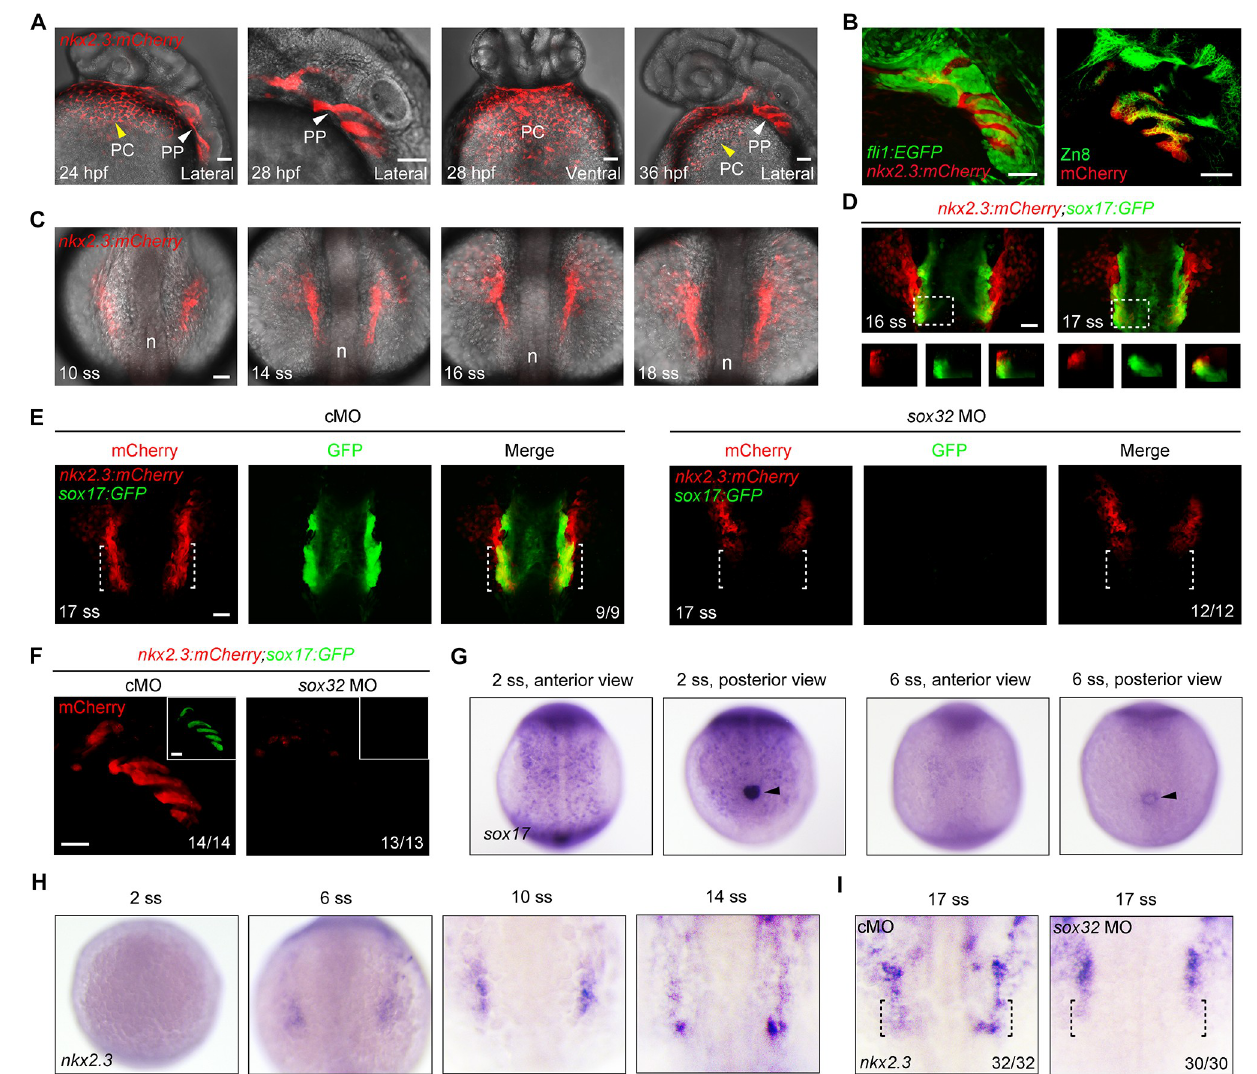
Fig 1. nkx2 . 3 is expressed in the lateral pharyngeal endoderm during early somite stages. ( A ) Tg(nkx2 . 3 : mCherry) embryos at 24, 28 and 36 hpf exhibiting fluorescence in the pericardium (yellow arrowhead) and pharyngeal pouches (white arrowhead). PC, pericardium; PP, pharyngeal pouch. Scale bars, 50 μ m. ( B ) mCherry-positive cells (red) were located between EGFP-labeled cranial neural crest cells (green) in Tg(nkx2 . 3 : mCherry;fli1 : EGFP) embryos (left panel), and co-localized with Zn8 labeled pharyngeal pouch cells (green) in Tg(nkx2 . 3 : mCherry) embryos (right panel). Scale bars, 50 μ m. ( C ) mCherry fluorescence in Tg(nkx2 . 3 : mCherry) embryos from the 10- to 18-somite stages. Embryos were dorsal views with anterior to the top. n, notochord; ss, somite stage. Scale bar, 50 μ m. ( D ) Tg(nkx2 . 3 : mCherry;sox17 : GFP) embryos with mCherry-positive cells (red) and GFP-labeled endodermal cells (green) at the 16- and 17-somite stages. The lower panels are optical transverse sections (XZ) taken at the level of white lines in their respective upper panels. Scale bar, 50 μ m. ( E-F ) mCherry (red) and GFP (green) fluorescence in Tg(nkx2 . 3 : mCherry;sox17 : GFP) embryos injected with 8 ng control MO (cMO) or 8 ng sox32 MO at the 17-somite stage (E) and 36 hpf (F). In panel F, the GFP fluorescence was shown in the inset. The ratios of affected embryos are indicated. White dotted lines highlight the lateral pharyngeal endoderm. Scale bars, 50 μ m. ( G-H ) In situ hybridization of sox17 (G) and nkx2 . 3 (H) expression in wild-type embryos at indicated developmental stages. Black arrowheads in (G) indicate the KVs. ( I ) Alteration of nkx2 . 3 expression pattern in 8 ng sox32 MO injected embryos at the 17-somite stage. Black dotted lines show the lateral pharyngeal